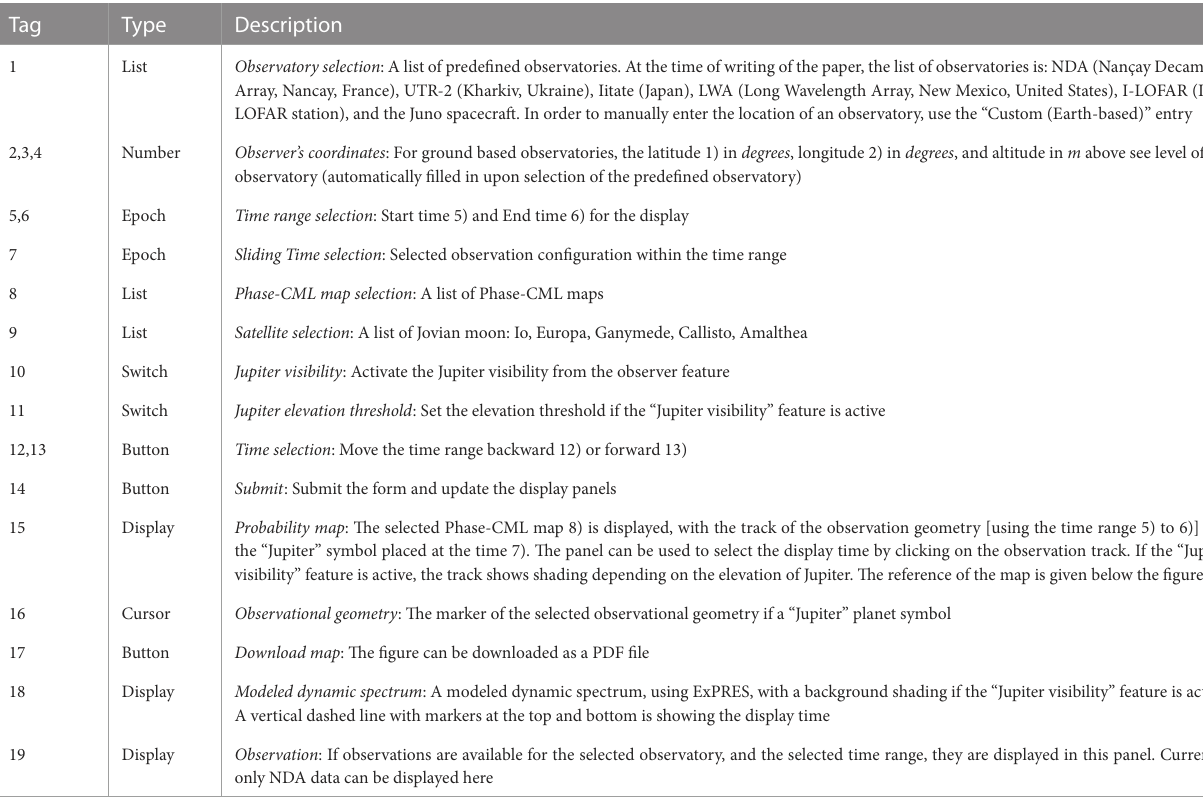
TABLE1 Featuresoftheapplicationgraphicaluserinterface,withtheirtype. List itemsaredrop-downmenuswithpredefinedvalues. Number itemsaretext boxeswithdecimalnumbersinput. Epoch itemsaretextboxeswithdateandtimeinput. Switch itemsarebuttonstoactivateafeature. Button itemsareusedto triggeranaction. Display itemsareshowingtheresultofthequery. Cursor itemsareactionableobjectsallowingtoselectalocationwithinarange.